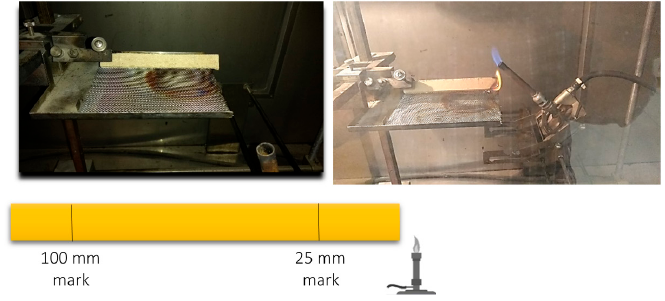
Figure 2. Burning test set-up in the enclosed laboratory hood and test specimen.